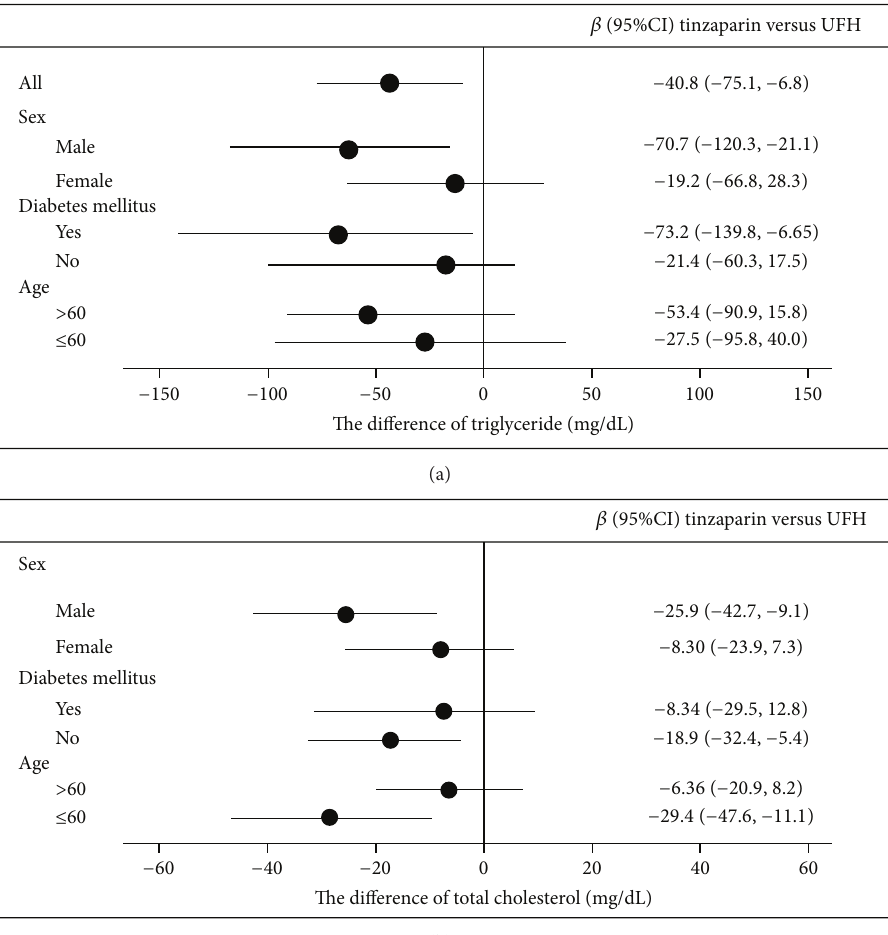
Figure 2: Subgroup analysis of the effect of tinzaparin on (a) serum triglyceride levels and (b) serum total cholesterol level in hemodialysis patients. The model for serum triglyceride levels was adjusted for sex, body mass index, systolic blood pressure, hemodialysis time, total iron-binding capacity, sodium, phosphate, and uric acid. The model for serum total cholesterol levels was adjusted for sex, diabetes mellitus, albumin, hemoglobin, hemodialysis time, and total iron-binding